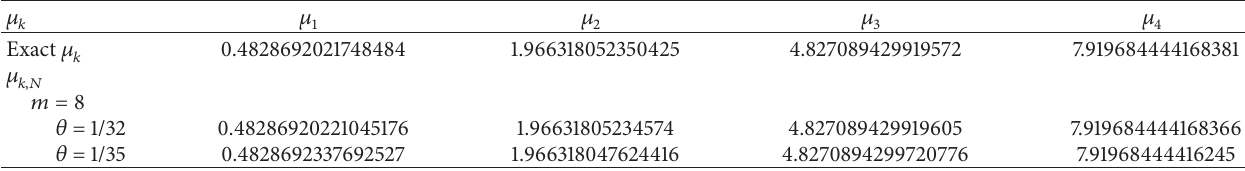
Table 4: With 𝑁 = 40 , the approximation 𝜇 𝑘,𝑁 and the exact solution 𝜇 𝑘 for different choices of 𝜃 .